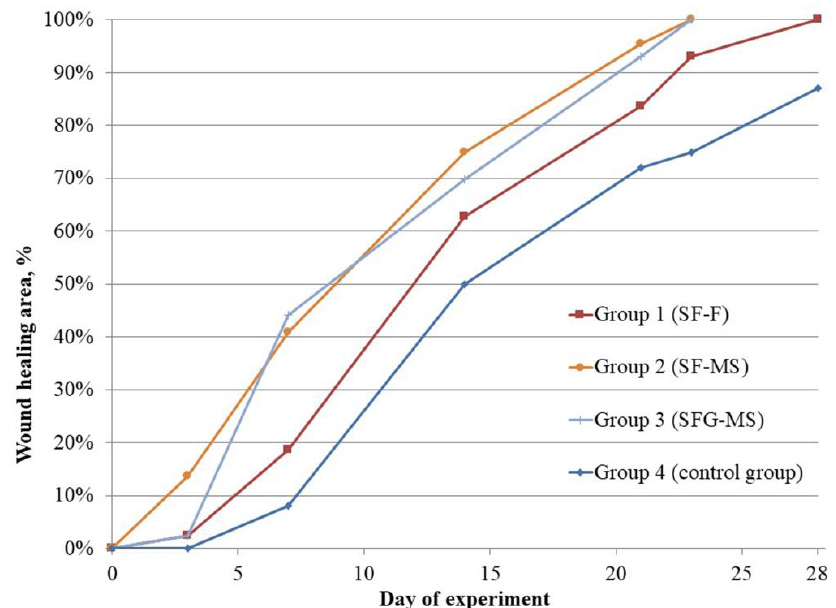
Figure 7. Healing curves of the full-thickness skin wounds.